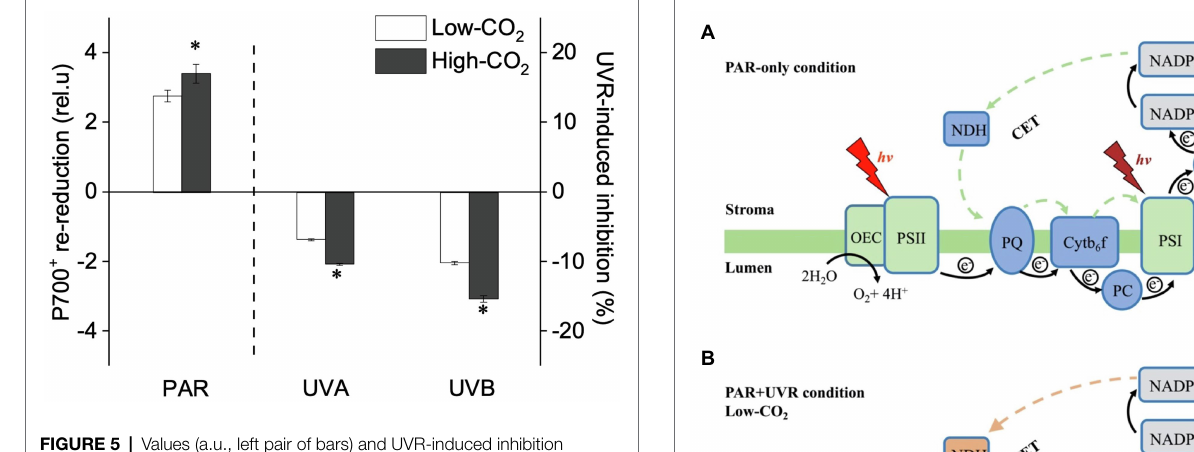
FIGURE 5 | Values (a.u., left pair of bars) and UVR-induced inhibition (%, right two pairs of bars) of CET activity (the P700 + re-reduction rate) of P. yezoensis growing for 9 days at low (~400 μ atm, open bars) and high (~1000 μ atm, closed bars) CO 2 conditions. Data are means ± SD ( n = 3). The symbols “*” indicates a significant ( p < 0.05, t -tests) difference between the treatments in each pair.